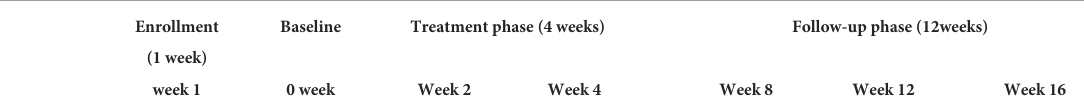
TABLE 1 Study schedule showing the time points for enrollment and assessment.